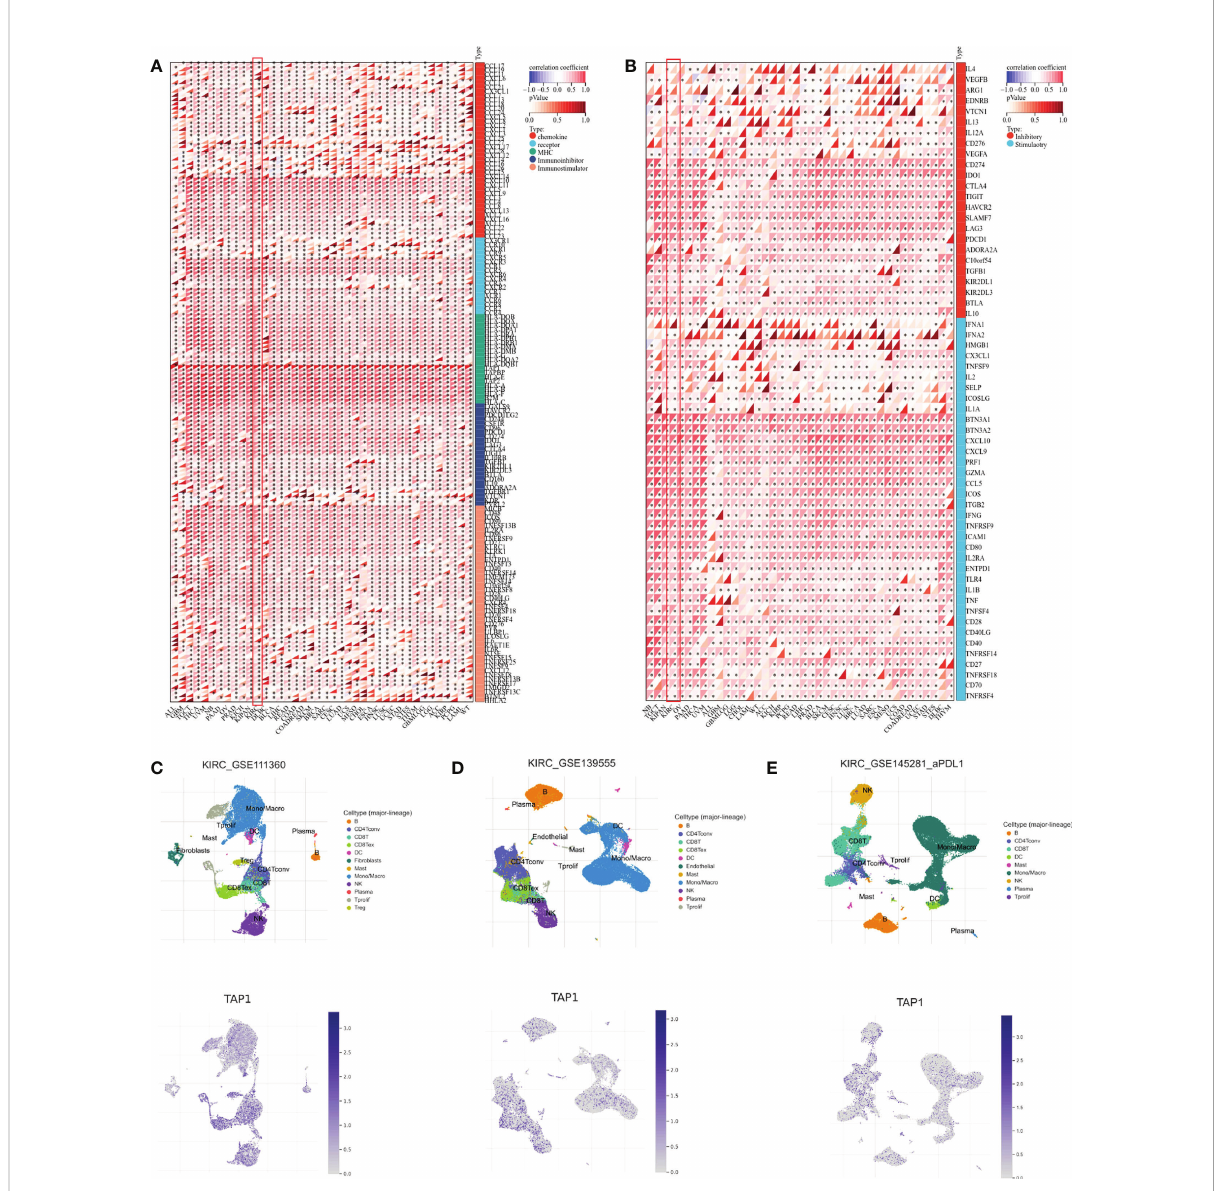
FIGURE 5 Association between TAP1 and tumor immunity in pan-cancer. (A) Landscape of immune regulator genes based on TAP1 expression 39 cancer types, including chemokine, receptor, major histocompatibility complex (MHC), Immuno-inhibitor, Immuno-stimulator. (B) Landscape of immune checkpoint-related genes based on TAP1 expression in 39 cancer types, including inhibitory and stimulatory. (C-E) Single-cell sequencing datasets GSE111360, GSE139555, and GSE145281 suggested localization of TAP1 mainly involve monocytes/macrophages, CD4+ and CD8+ T cells, B cells, mast cells, dendrite cells in ccRCC. *, P < 0.05; **, P < 0.01; ***, P < 0.001; ****, P <